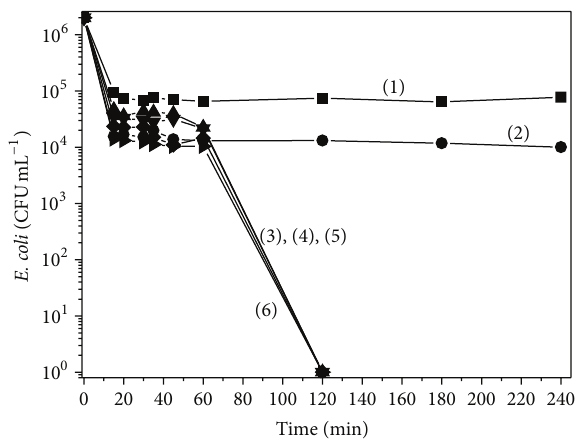
Figure 13: Loss of bacterial viability in the dark mediated by TiO 2 - polyester (HT) prepared samples with different TiO 2 loadings: (1) polyester alone, (2) 0.05%, (3) 0.1%, (4) 0.5%, (5) 1%,and (6) 5%.